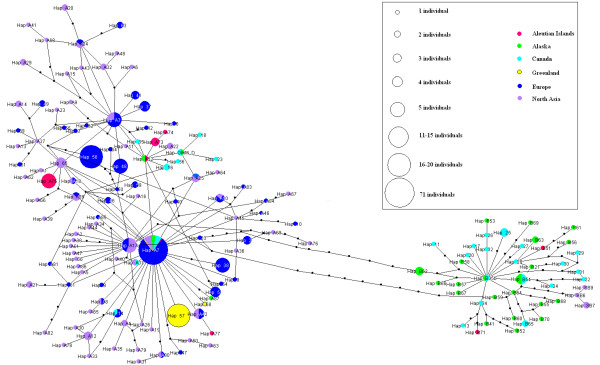
Unrooted network illustrating the phylogenetic relationships of the mtDNA haplotypes. Haplotype names correspond to the ones in Additional file 1 and colours to regions as indicated in Table 1. Circle sizes scale to indicate the number of individuals harbouring each haplotype. Small black dots indicate unsampled intermediate haplotypes. Note that distances between circles are not proportional to the genetic distance but are arranged for better visibility.